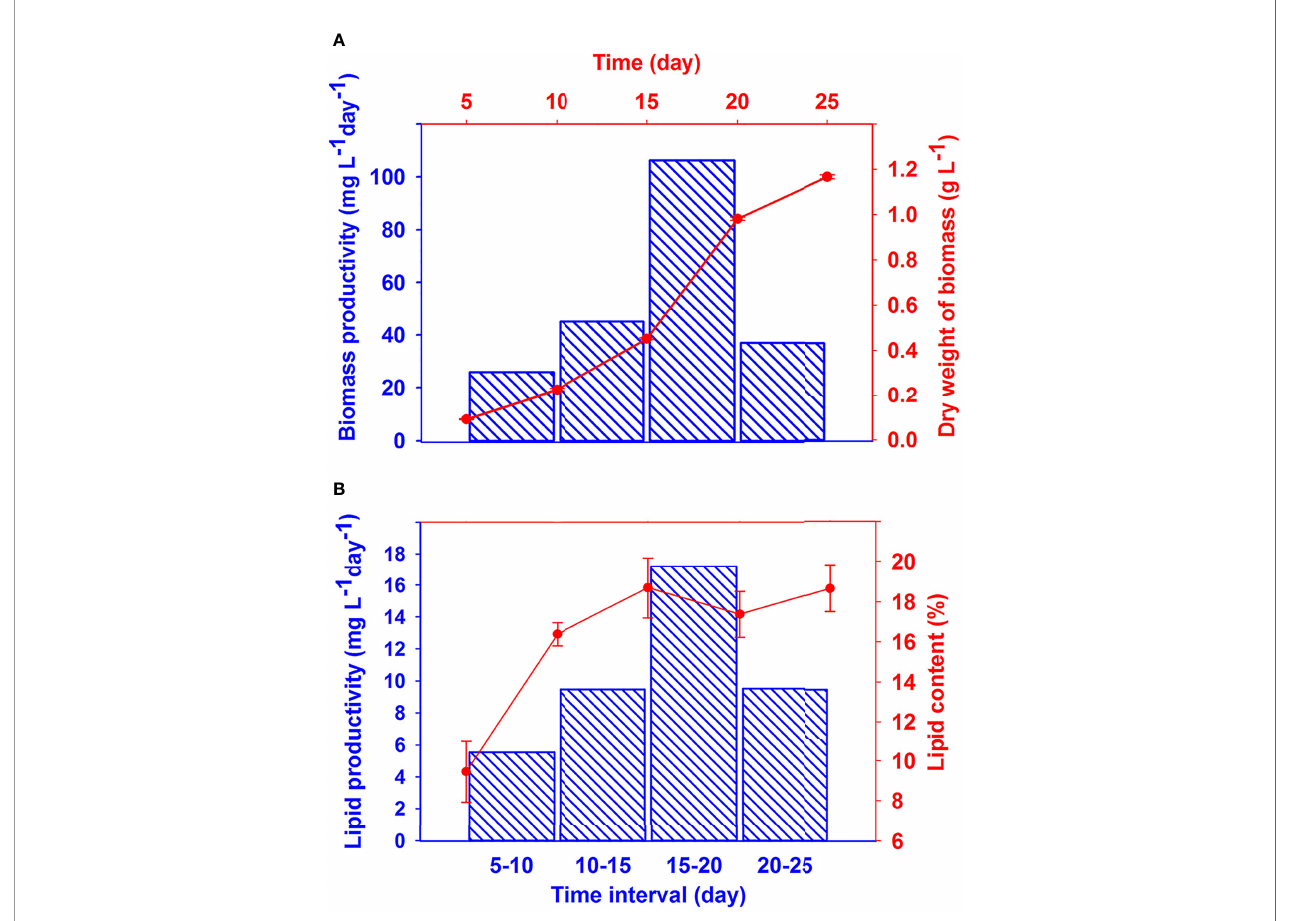
FIGURE 2 | Biomass concentration and biomass productivity (A) , and lipid content and lipid productivities (B) of C. vulgaris as a function of time. Top and right axes belong to the scatter plots and bottom and left axes belong to the bar